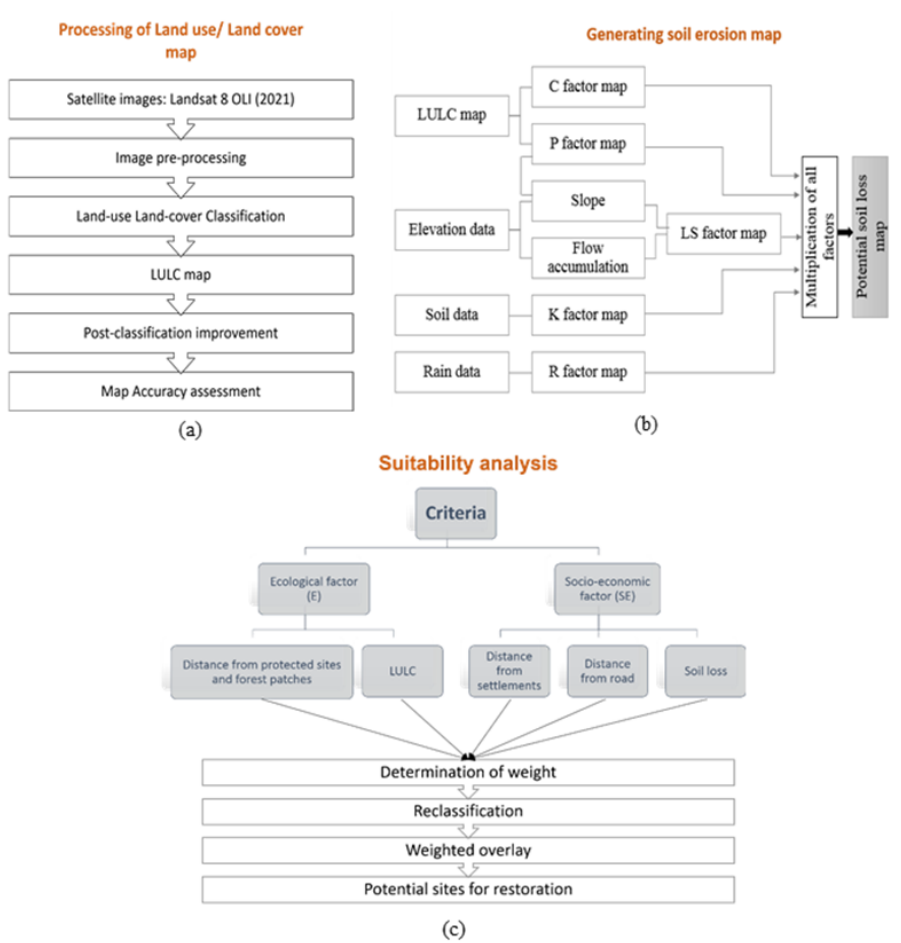
Figure 4. Research framework for land suitability analysis to propose the priority areas for landscape restoration ( a ) Land use/Land cover classification processing. ( b ) Soil erosion map processing, ( c ) Land suitability analysis.